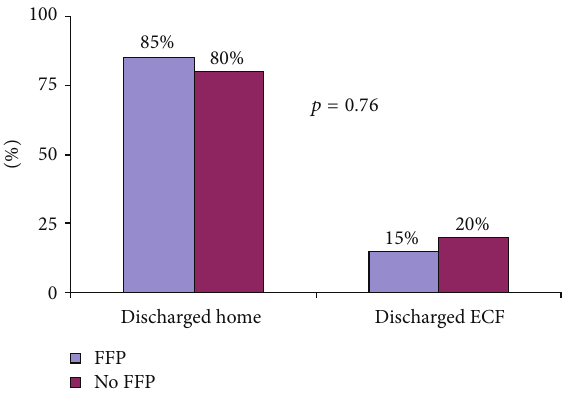
Figure 4: Differences in group outcomes did not reach statistical significance. FFP, fresh frozen plasma; ECF, extended care